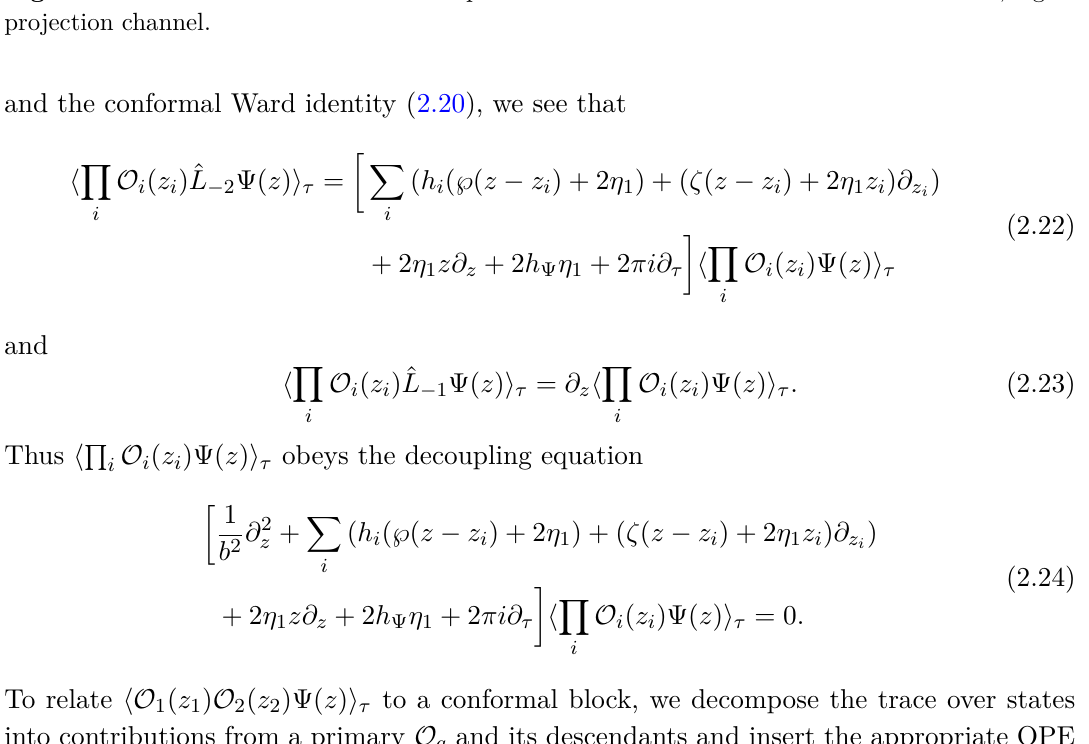
Figure 1 . Conformal blocks for the two point function on the torus. Left: OPE channel, right: projection